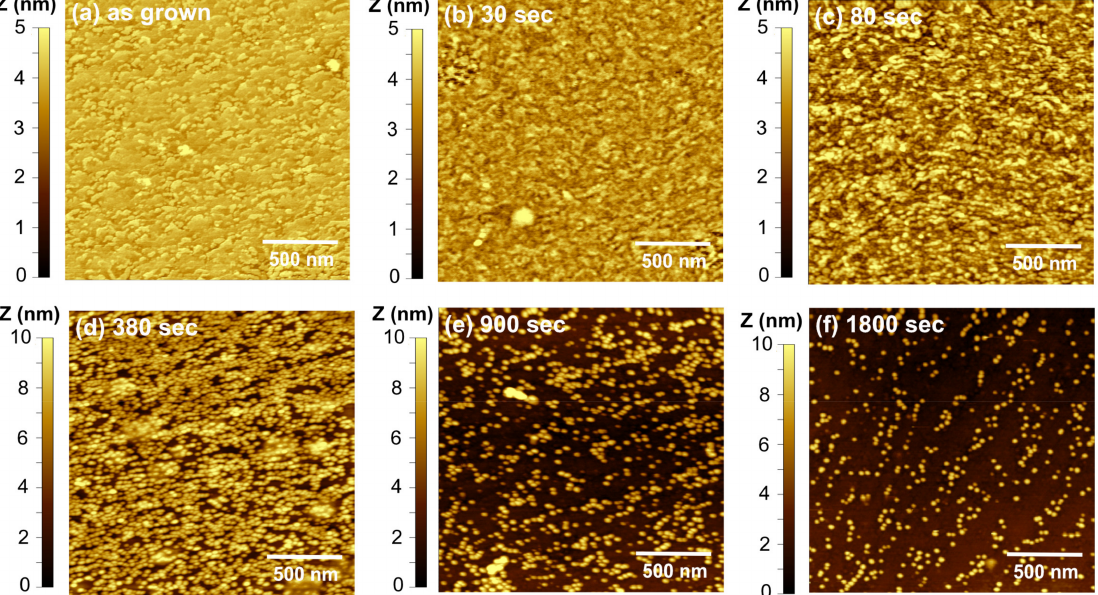
Figure 5. Atomic force microscope images exhibiting the progress of InGaN QD formation using PEC etching with a coherent light source at 0.4 V. The images are for the ( a ) as-grown surface and etched for ( b ) 30 s, ( c ) 80 s, ( d ) 380 s, ( e ) 900 s, and ( f ) 1800 s. The QDs formation is slower than at 0.9 V, and the QDs are fully formed at 380 s. QD density reduces from ~1 × 10 11 / cm 2 at 380 s to ~1.2 × 10 10 /cm 2 at 1800